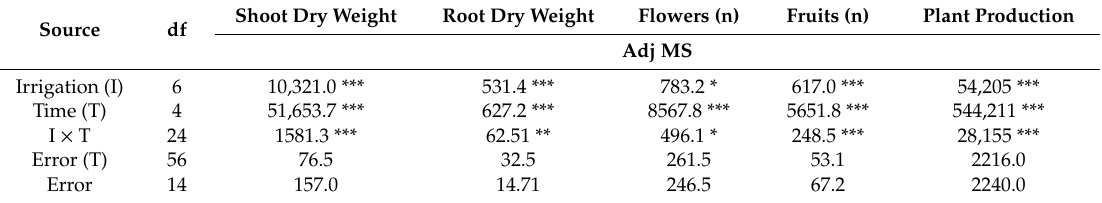
Table 3. Repeated-measures ANOVA for the main e ff ects and interactions on plant production